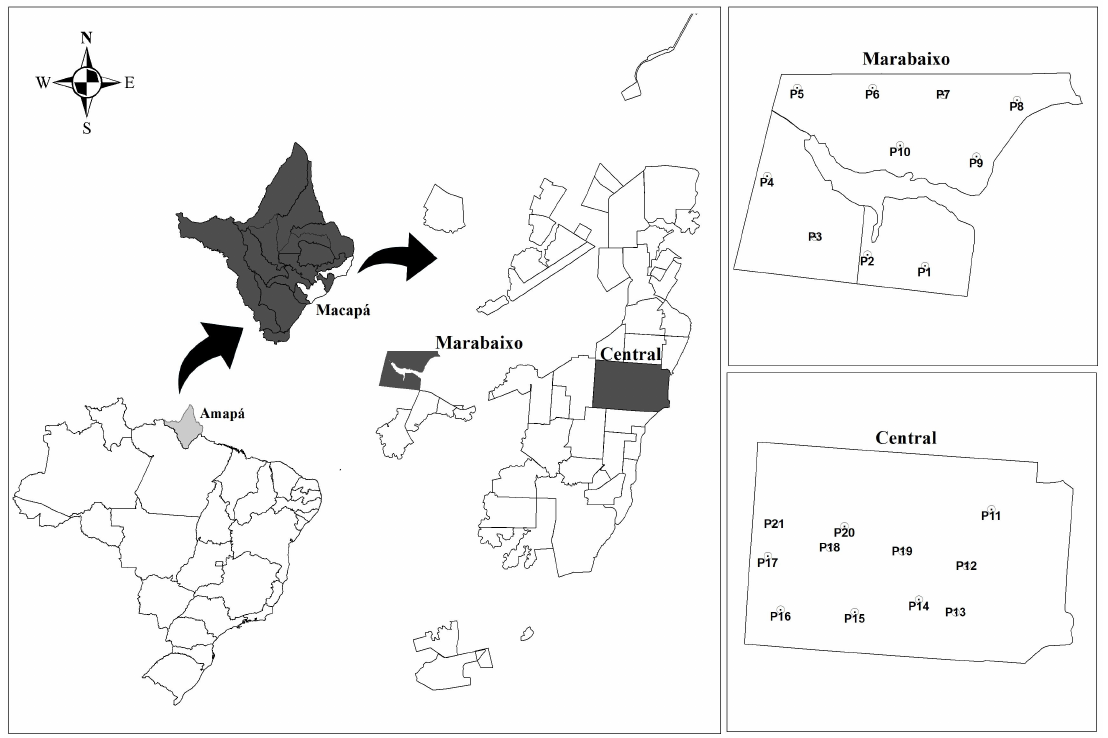
Figure 1. Location of the study area. From left to right: Map of Brazil highlighting the state of Amap á , map of Amap á highlighting the city of Macap á , map of Macap á highlighting the neighborhoods of Marabaixo and Central and maps of the two neighborhoods showing the 21 locations where mosquitoes were